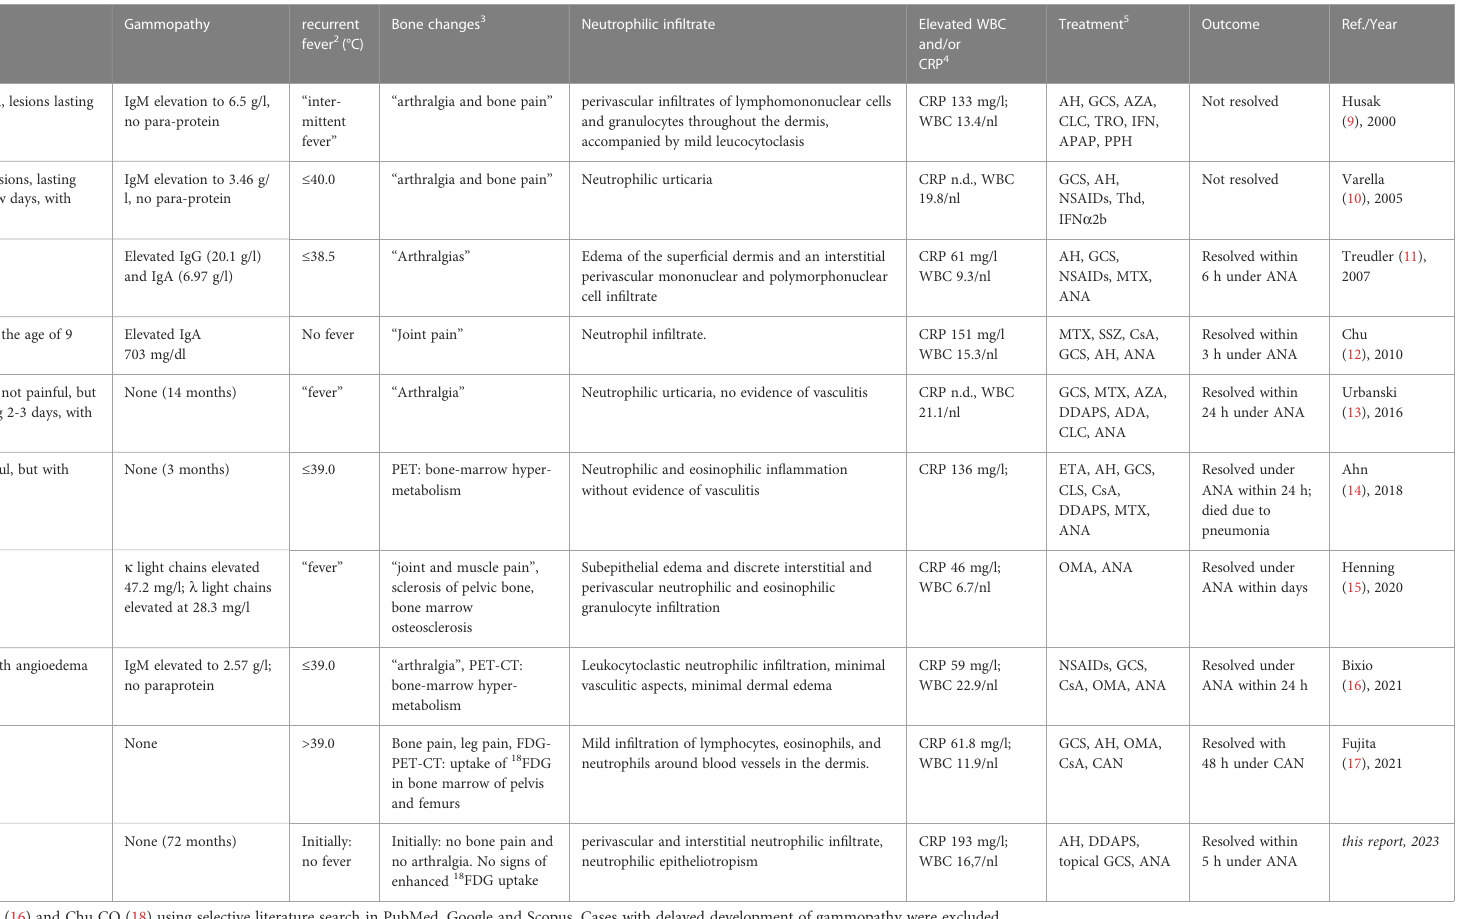
TABLE 1 Summary 1 of published cases with Schnitzler-like syndrome without monoclonal